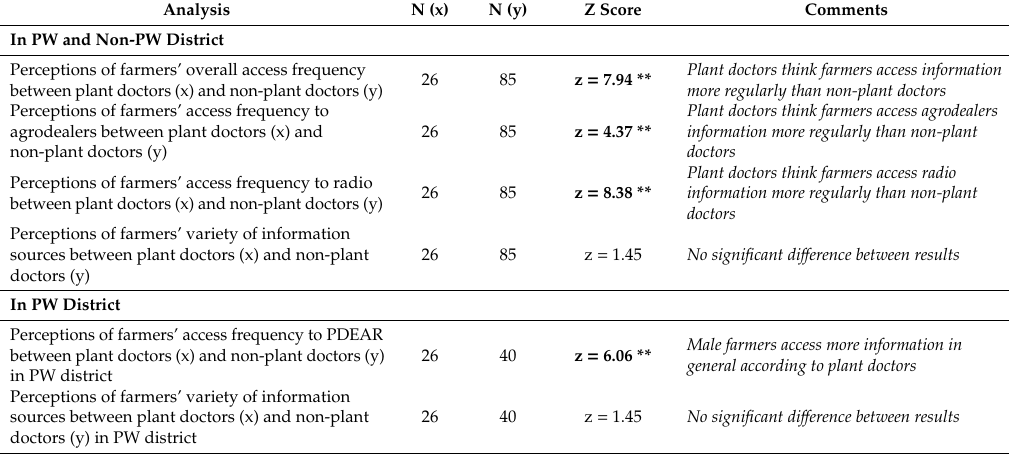
Table 3. Plant doctors and non-plant doctors’ perceptions of farmers information access in PW and non-PW districts. Comparing Plant Doctors and Non-Plant Doctors’ Perceptions of Male Farmers’ Information